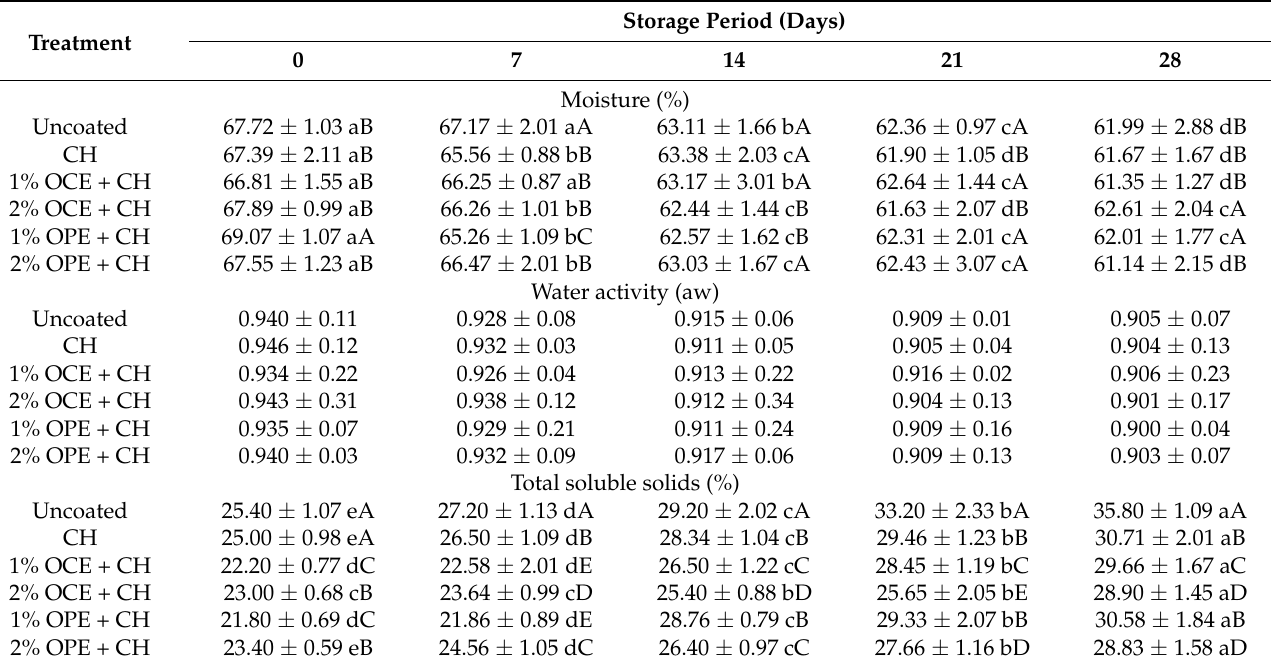
Values are means of triplicate samples ( ± SD). Means not sharing common lowercase letters in a row or capital let- ters in a column are significantly different at p ≤ 0.05 as assessed by Duncan’s Multiple Range Test. CH = Chitosan, OCE = Olive cake extract, OPE = Orange peel